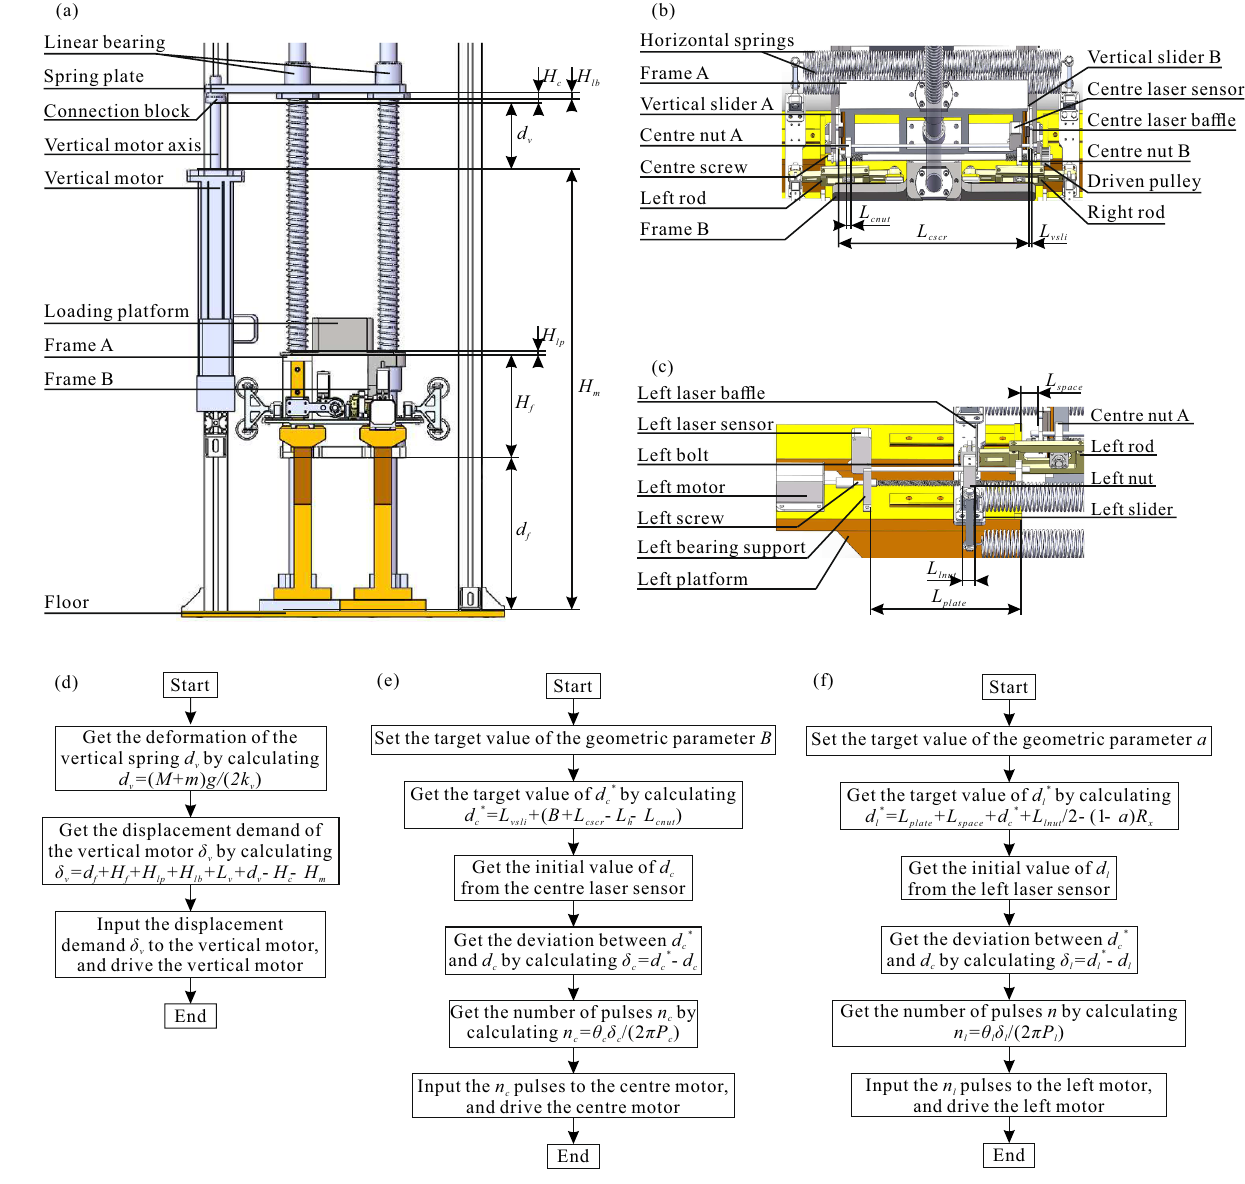
Figure 5. Details of the control systems of the prototype ( a ) for the partial enlarged of the vertical motor adjusting structure; ( b ) for the partial enlarged of the centre motor adjusting structure; ( c ) for the partial enlarged of the left motor adjusting structure; ( d ) for the logic block diagram of control strategy of the vertical motor adjusting structure; ( e ) for the logic block diagram of control strategy of the centre motor adjusting structure; and ( f ) for the logic block diagram of control strategy of the left motor adjusting